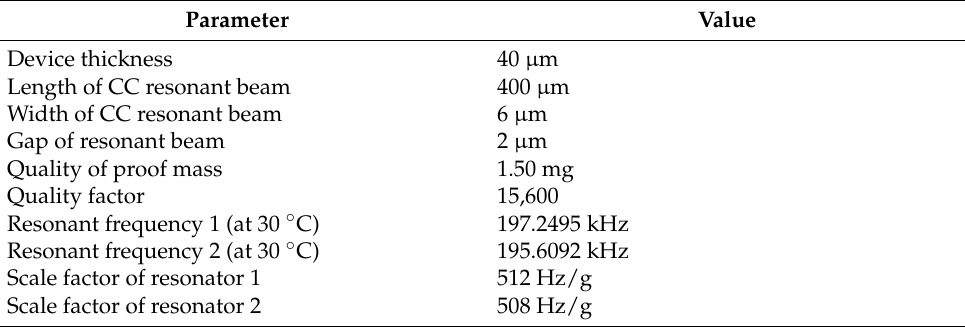
Table 1. Parameters of the accelerometer.